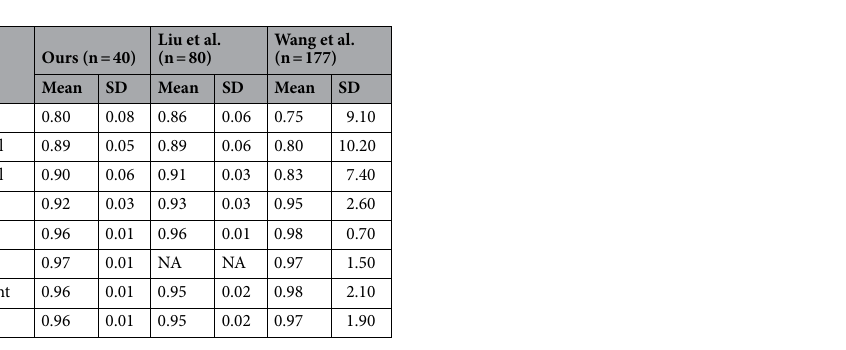
Table 4. Dice similarity coefficient comparison between our tool and other state-of-the- art upper-abdominal auto-segmentation models.